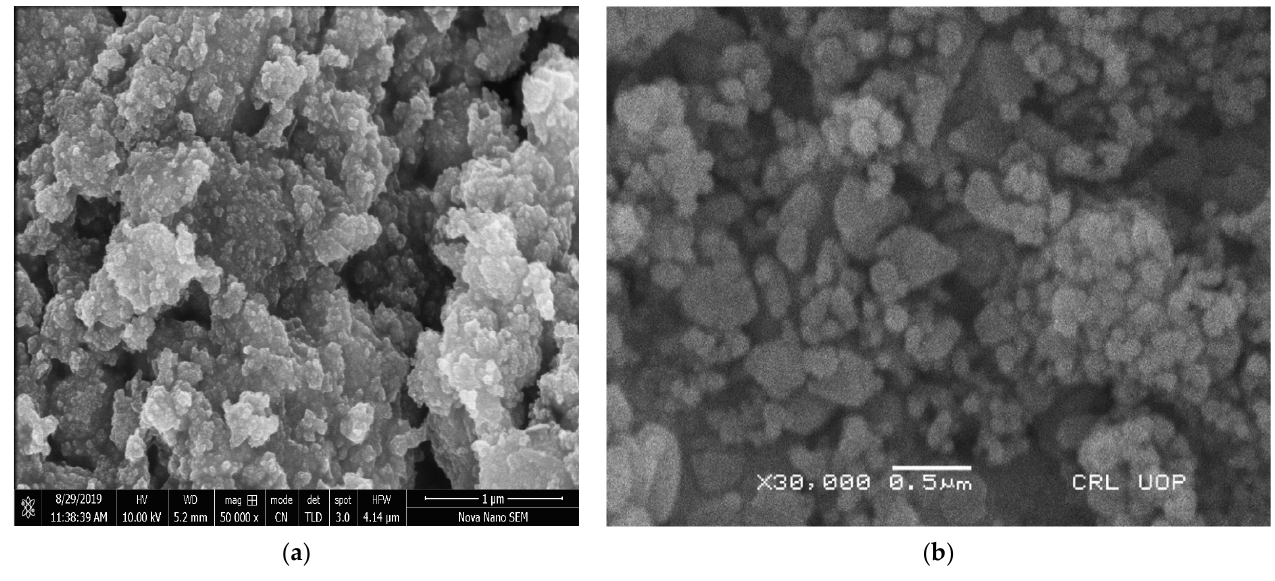
Figure 1. SEM images of Zn/iron oxide NPs. ( a ) 1 µm ( b ) 0.5 µm scales.